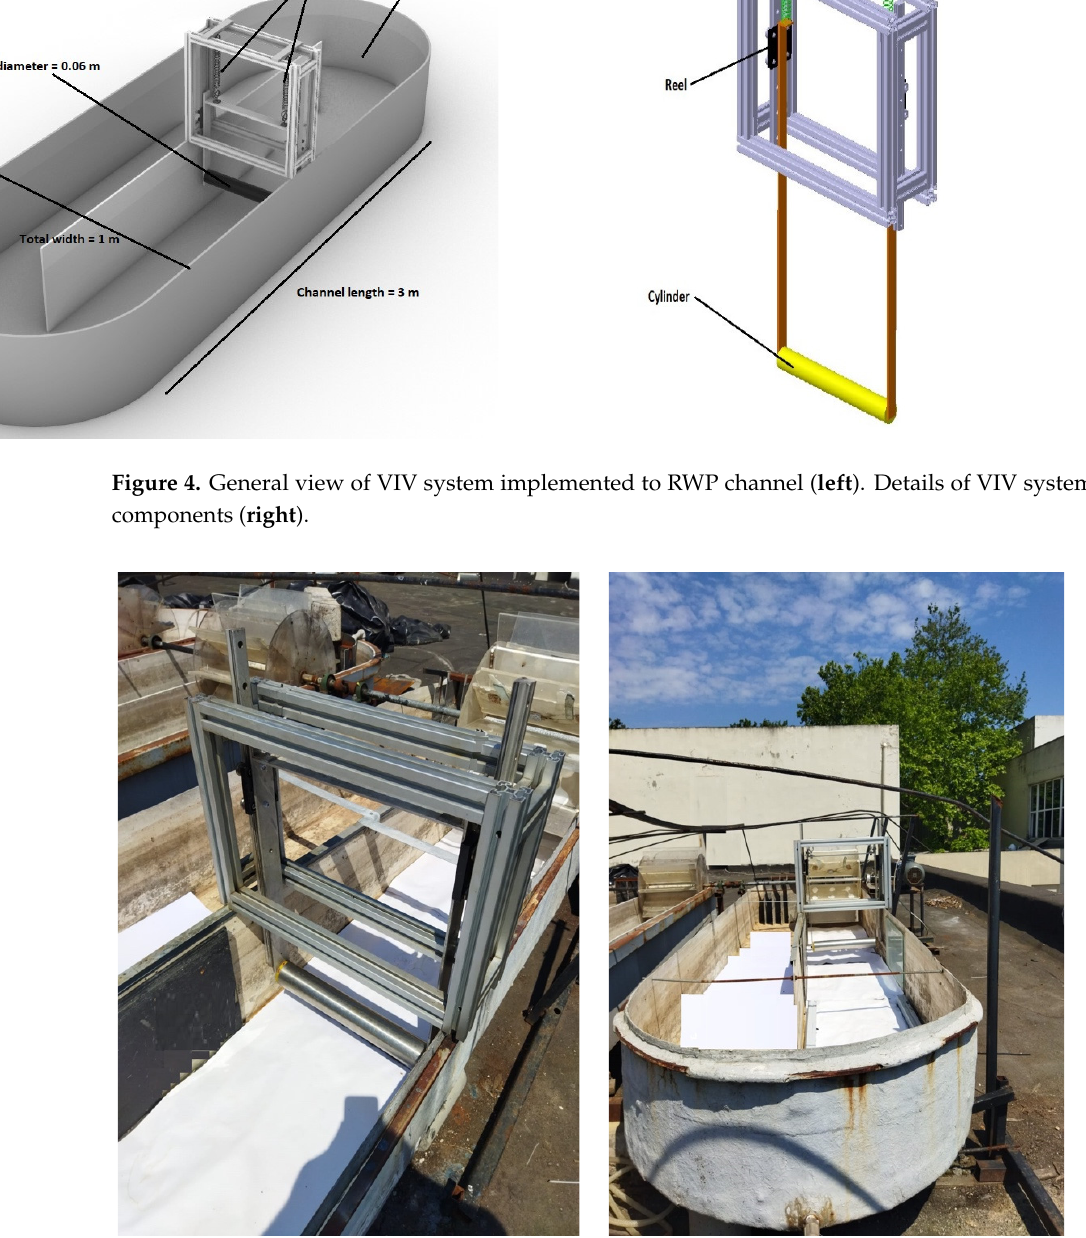
Figure 6. Positions of cylinder during one oscillation (not to scale).